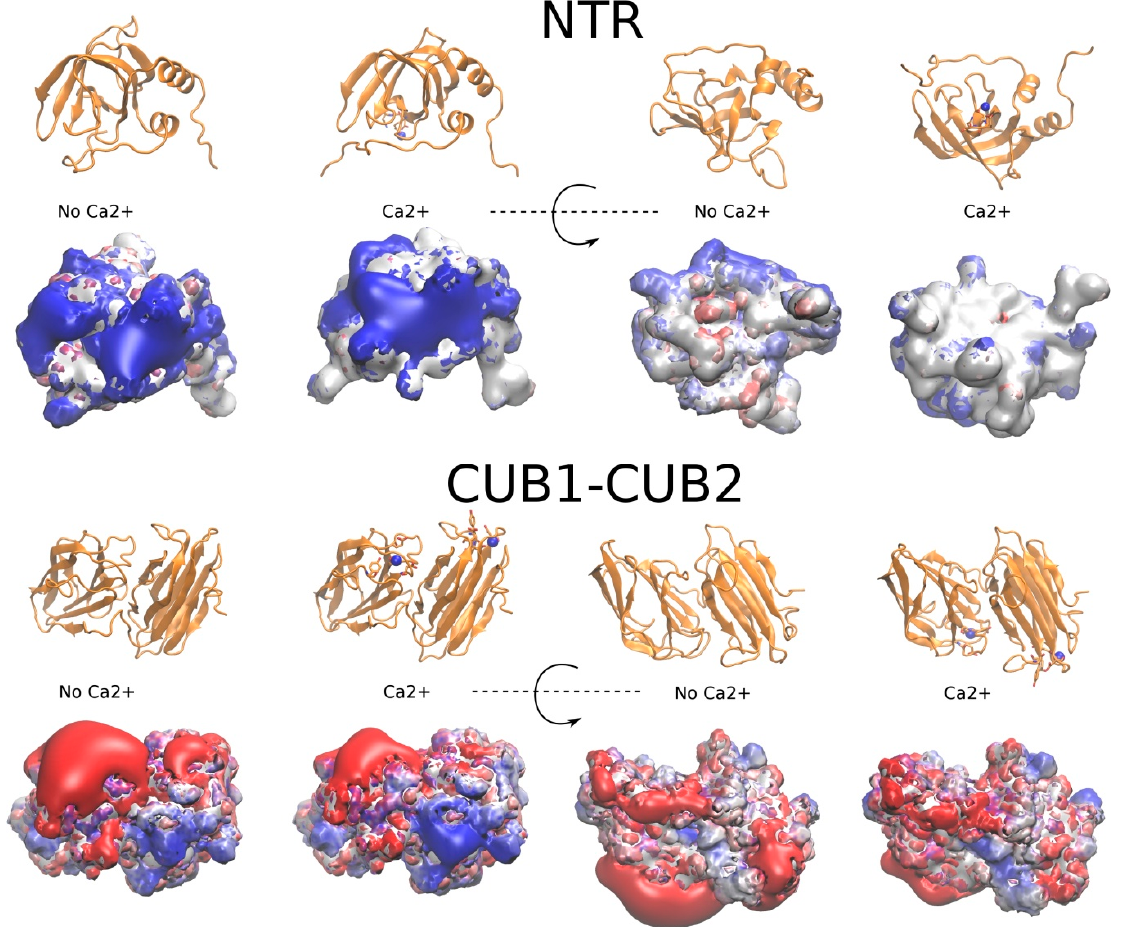
Figure 5. Electrostatic potential isosurfaces (blue, positive; red, negative) of NTR (–2.5 kcal/mol·e − 1 and 1.0 kcal/mol·e − 1 ) and CUB1-CUB2 (–3 kcal/mol·e − 1 and 3 kcal/mol·e − 1 ) domains in the presence and in the absence of Ca 2+ ions obtained by PBSA calculations. Protein domains are shown in cartoon with the residues coordinating Ca 2+ ions in licorice representation; Ca 2+ ions: blue spheres.